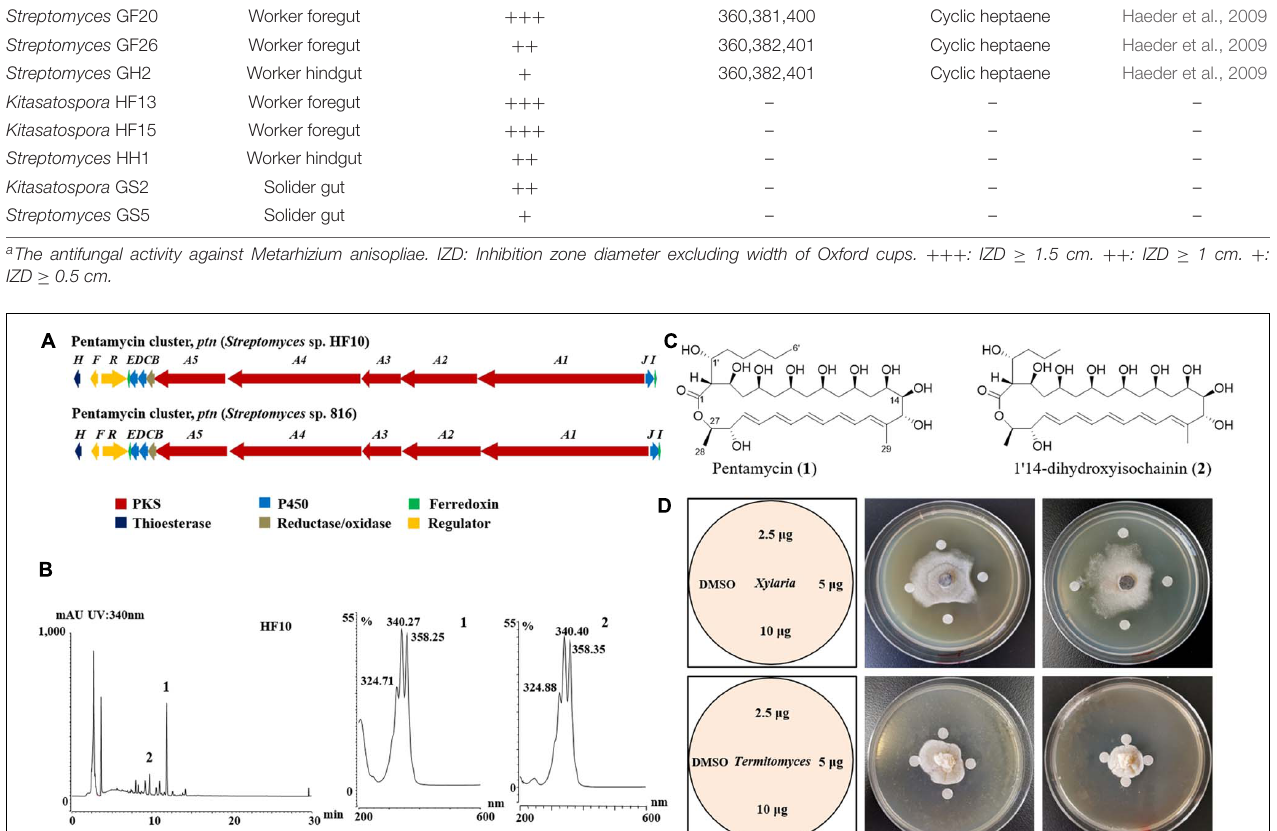
Streptomyces sp. S816 ( Figure 3A and Supplementary Table 3 ; Zhou et al.,